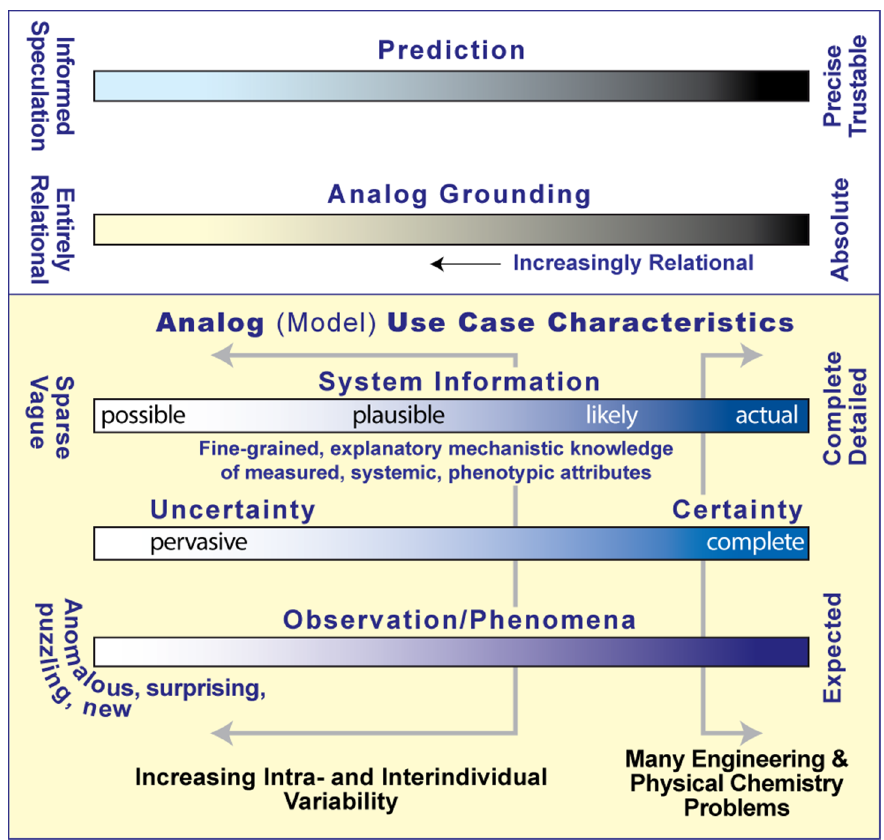
Figure 5. Analog use cases. Each analog experiment (a use case) focuses on one or more aspects of its referent, e.g., felodipine plasma profiles. The particular referent can be characterized by its approximate location on each of the four lower spectra. Those locations guide analog grounding decisions and constrain the characteristics of predictions that the validated analog can make. An analog, in turn, can be located anywhere along a spectrum of software devices (models) ranging from synthetic (used herein) to purely inductive models. Conditions on the far right of the three lower spectra are supportive of continuous mathematical models that are constrained by their formalism and rely on absolute grounding that, upon validation, can make trustable, precise predictions. When center-left, where explanatory, mechanistic knowledge is scarce, the focus needs to shift to mechanism discovery, explanation, and exploration, which are facilitated by relational grounding [7,31], and reliance on the agent-oriented, discrete event methods used herein is most